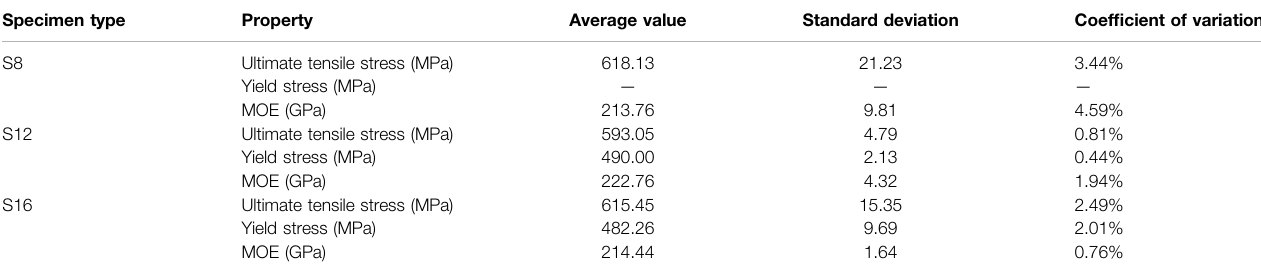
TABLE 2 | Bearing capacity and strength of dowel tensile specimens. Specimen type